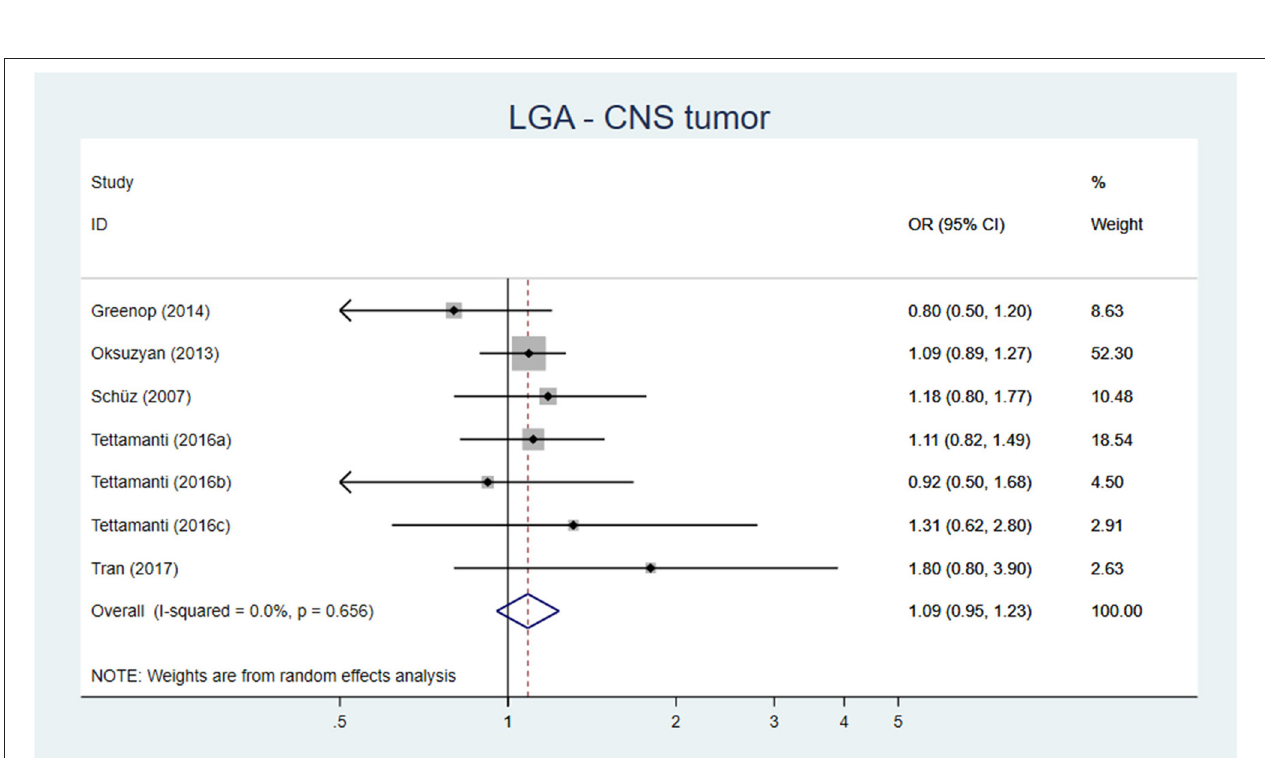
FIGURE 3 | Forest plot describing the association between high birth weight and CNS tumors.